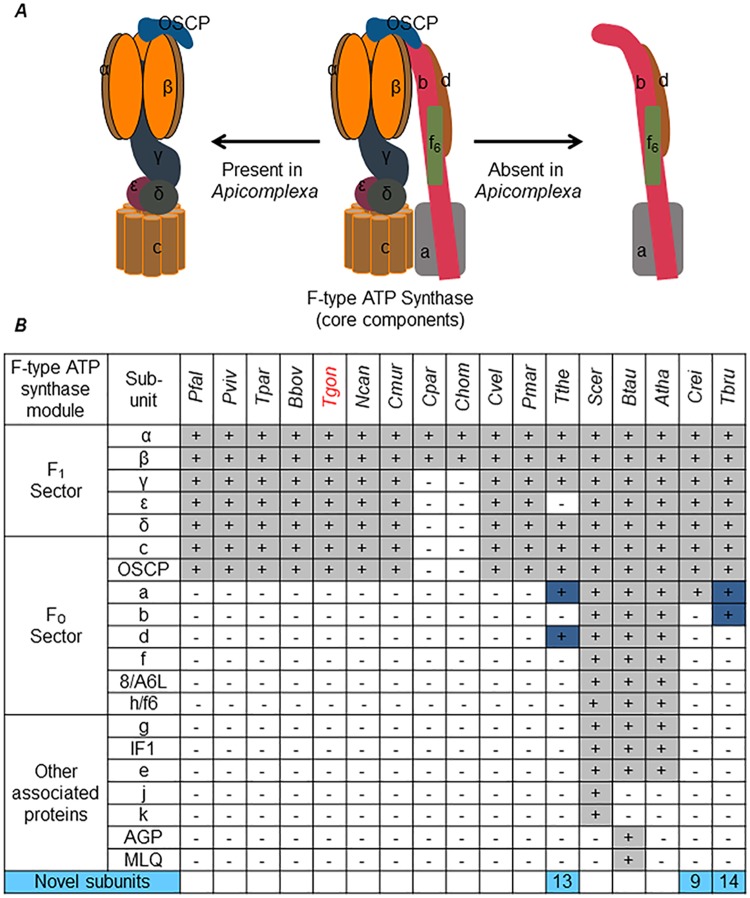
Detail of F-type ATP synthase subunits missing in T. gondii and other apicomplexan parasites.(A) Schematic representation of core subunit composition of F-type ATP synthase. The different subunits are color coded and annotated. Middle, the complete set of subunits of the core enzyme; left and right, subunits identified and not identified by in silico methods in apicomplexan genome. (B) Table showing the presence/absence of orthologs of yeast and bovine F-type ATP synthase in Apicomplexa and other alveolate species. +/−, presence/absence of ortholog; blue, diverged (no clear orthologs) functional equivalent; light blue, experimentally identified species-specific novel subunits (numeric values indicate the total number of such novel subunits). Species names: Pfal, P. falciparum; Pviv, Plasmodium vivax; Tpar, Theileria parva; Bbov, Babesia bovis; Tgon, T. gondii; Ncan, Neospora caninum; Cmur, Cryptosporidium muris; Cpar, Cryptosporidium parvum; Chom, Cryptosporidium hominis; Cvel, Chromera velia; Pmar, Perkinsus marinus; Tthe, T. thermophila; Scer, Saccharomyces cerevisiae; Btau, Bos taurus; Atha, Arabidopsis thaliana; Crei, Chlamydomonas reinhardtii; Tbru, T. brucei. IF1, inhibitory factor 1; OSCP, oligomycin sensitivity–conferring protein.